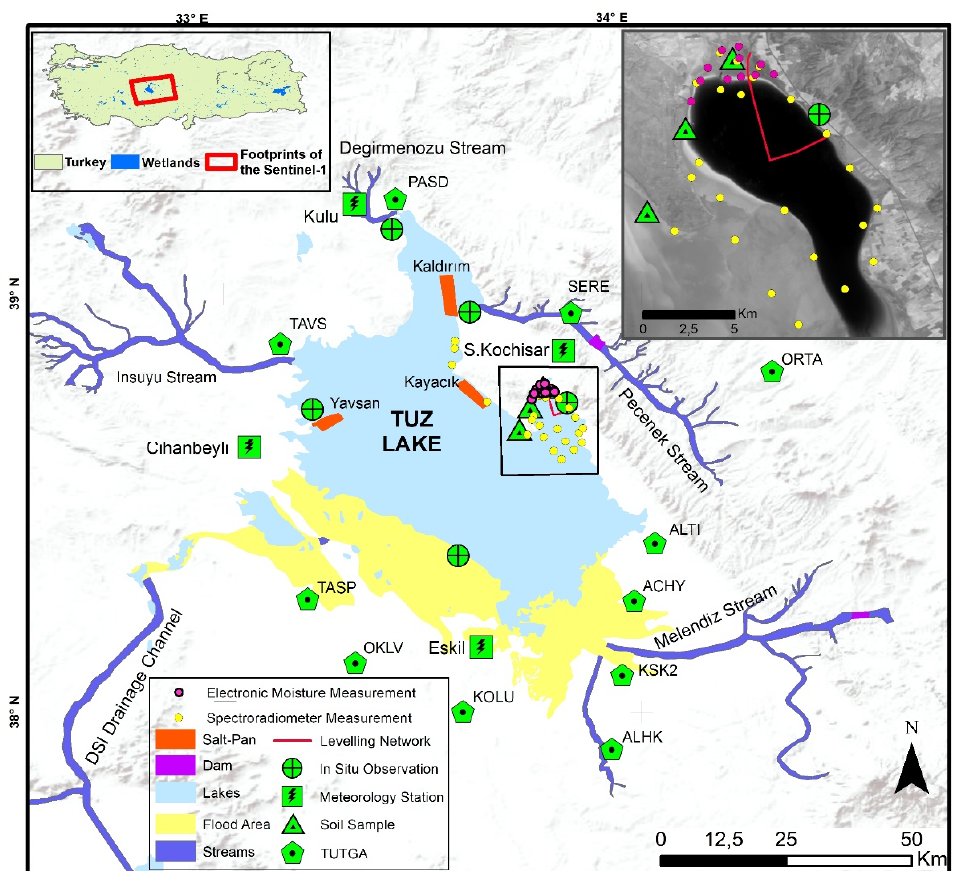
Figure 1. Geographic location of Lake Tuz overlaid on the hillside background, as well as the spatial distribution of the meteorological and hydrological stations and in situ areas used in this study. The reference area where the levelling measurement was carried out is enlarged.